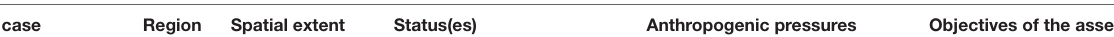
TABLE 5 | Assessments conducted using the protocol.